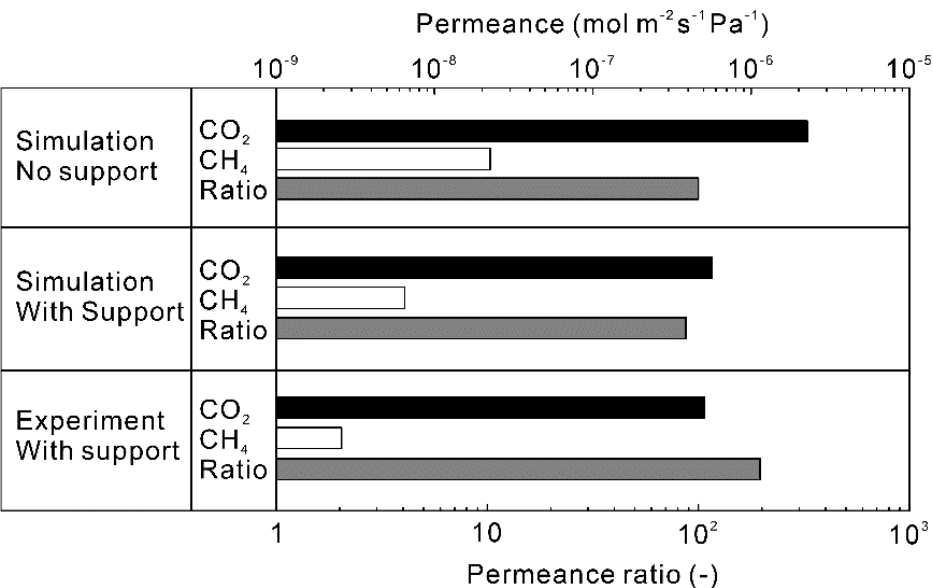
Figure 7. Comparison of simulated permeation properties of the CHA-type zeolite membrane with Si/Al = 18.2 to experimental results [28]. The permeation properties were calculated at CO 2 concentration = 50 vol%, total pressure = 300 kPa, and temperature = 323 K. The thickness of zeolite layer was 5 µ m, and the pore size, porosity and thickness of the support tube were 150 nm, 35% and 0.3 mm [24].